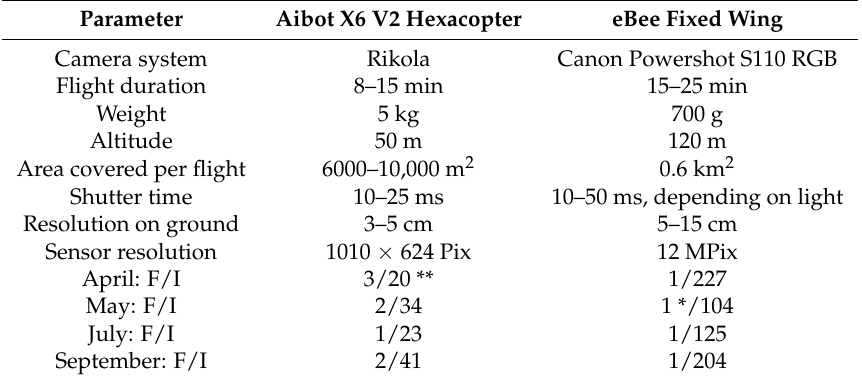
Table 3. UAS properties used for the Litov study. F = Flights; I =